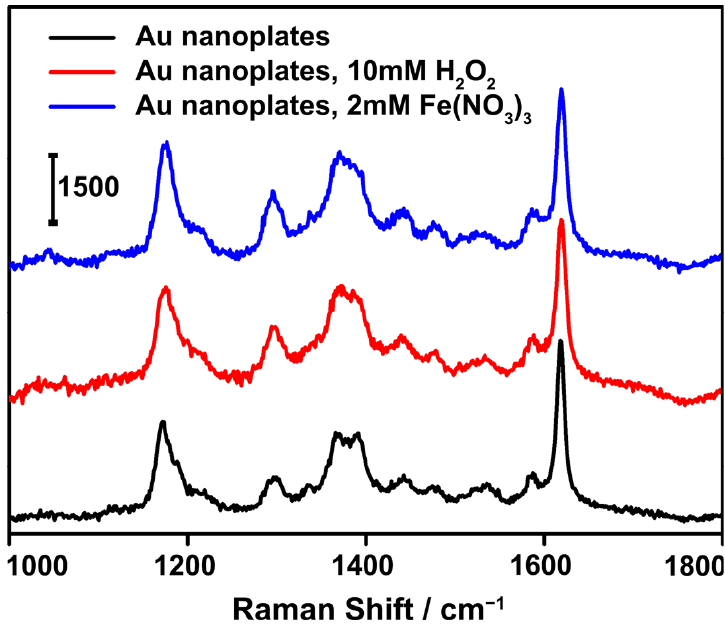
Figure 6. SERS analysis of crystal violet (concentration, 10 − 6 M) adsorbed on the substrates fabricated with the Au nanoplates. The SERS spectra in the presence of interfering species, i.e., 10 mM H 2 O 2 and 2 mM Fe(NO 3 ) 3 , are also listed for comparison.